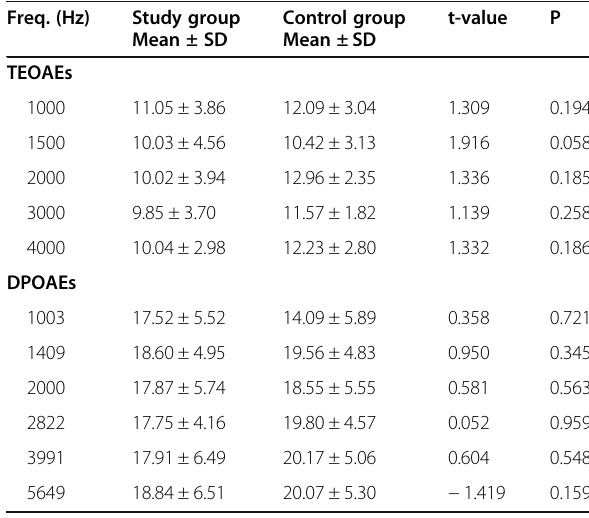
Table 3 Comparison between TEOAEs (absolute thresholds) and DPOAEs (signal to noise threshold levels) in study and control